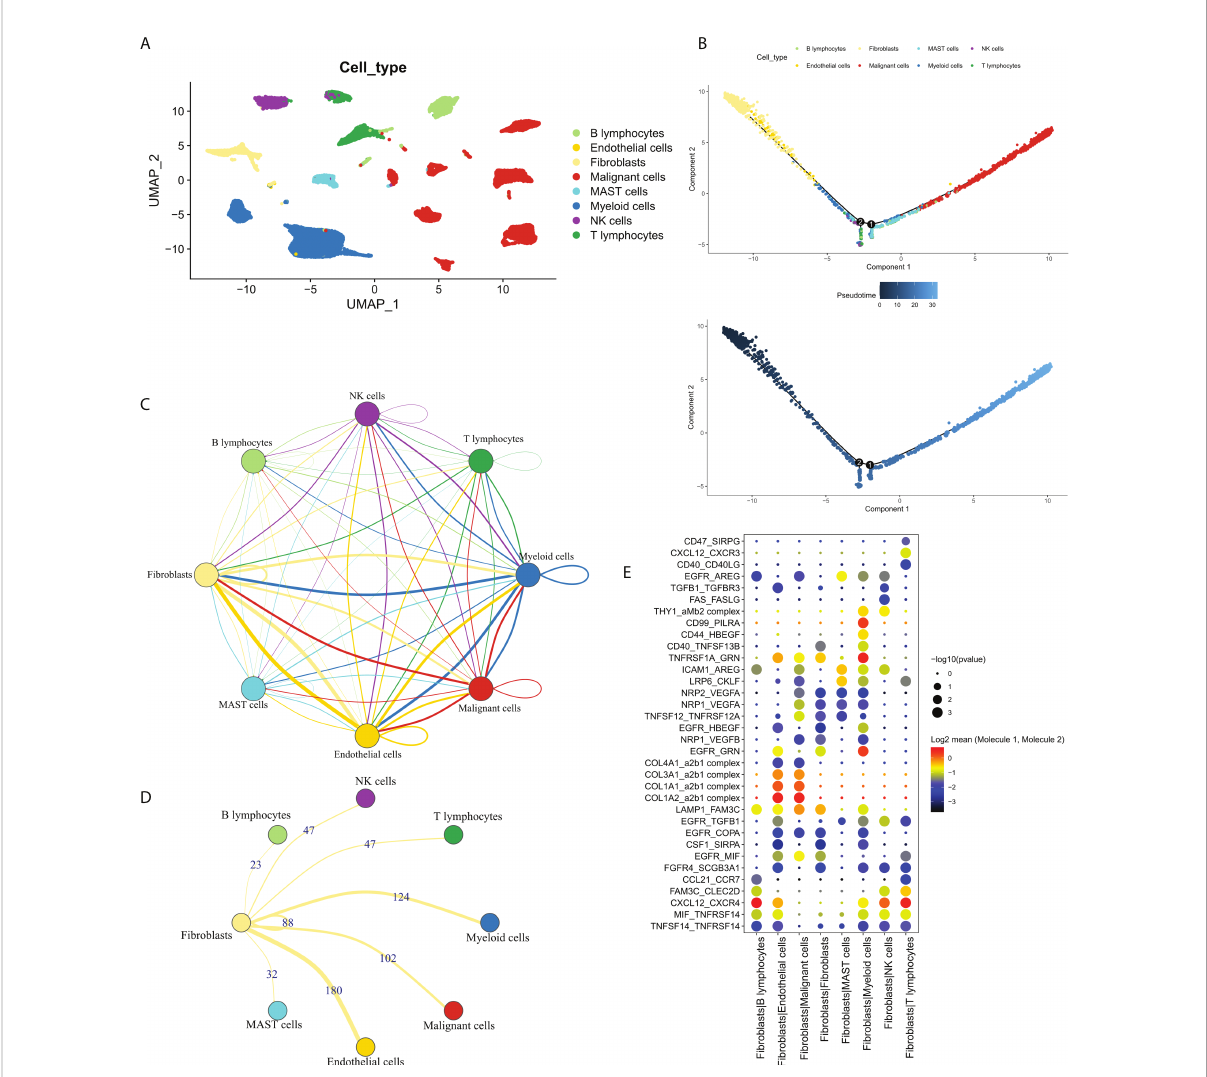
FIGURE 1 The single-cell pro fi le of CAFs. (A) Eight cell clusters identi fi ed by cell clustering; (B) Pseudo-time analysis of the eight-cell clusters. Upper panel: cell cluster distribution, lower panel: pseudo-time distribution; (C) Communication network of the eight-cell clusters; (D) Communication network of CAFs with other cells, wherein the numbers represent the number of receptor-ligand pairs; (E) The top 5 receptor-ligand pairs of CAFs communicating with other cell